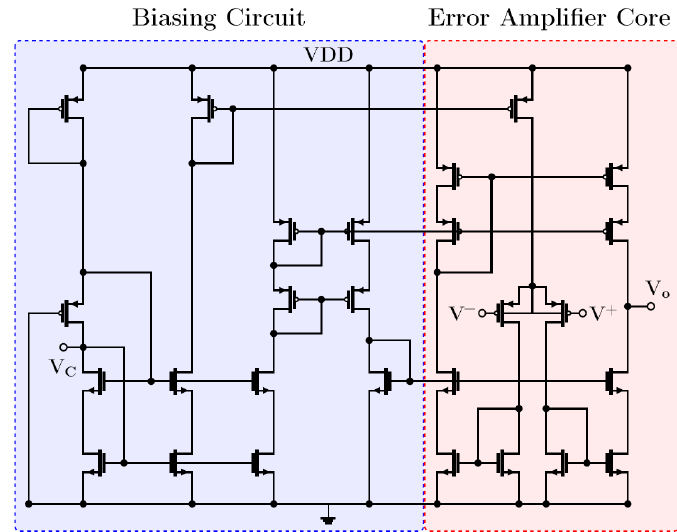
Figure 7. Schematic of the error amplifier.